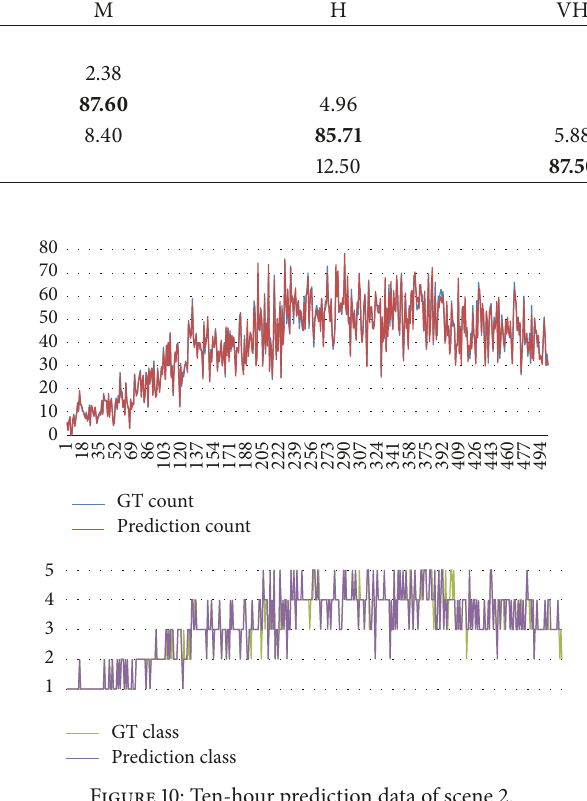
Figure 10: Ten-hour prediction data of scene